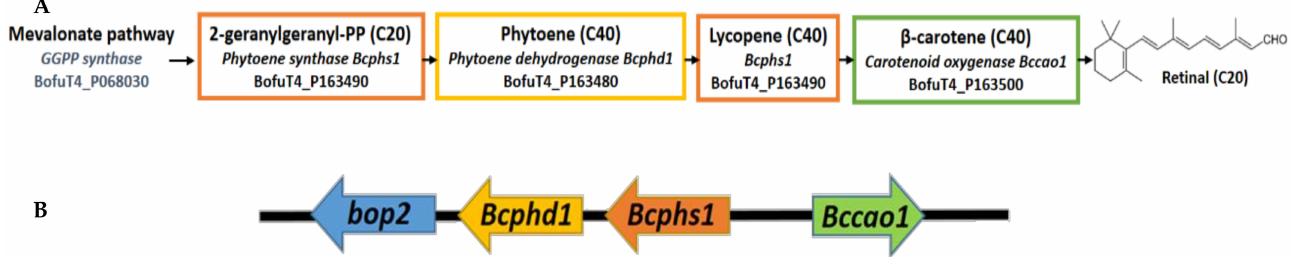
Figure 5. ( A ) Proposed pathway for carotenoid biosynthesis in B. cinerea . Genetic makeup may allow for the production of retinal as an end product of a branched pathway. ( B ) The genes required for retinal biosynthesis are physically linked with the opsin-encoding bop2 in B. cinerea .